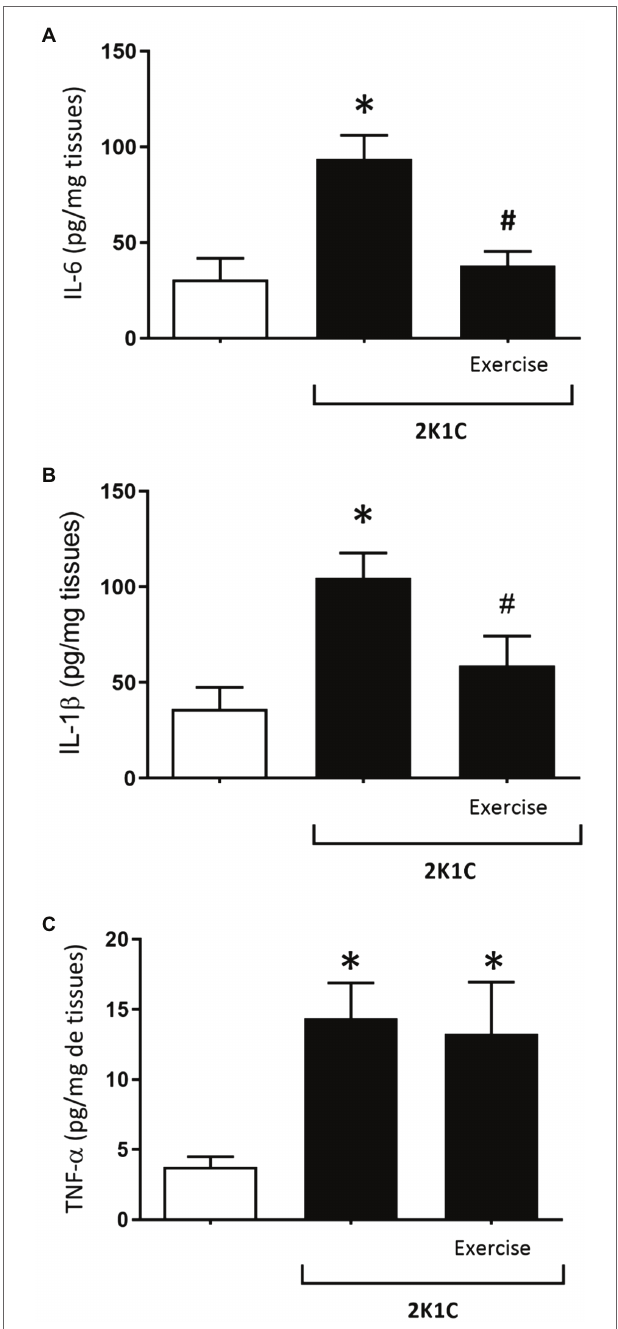
FIGURE 7 | Concentrations of interleukin 6 (IL-6) (A) , interleukin (IL-1 β ) (B) and tumor necrosis factor alpha (TNF- α ) (C) in the duodenum in hypertensive rats by the experimental model 2K1C. Experimental Groups: Sham; 2K1C; 2K1C + Exercise. For statistical analysis, mean ± SEM was used, by 2-way ANOVA, followed by Tukey or Kruskal-Wallis test. Significance: p <0.05: * vs. Sham, # vs.